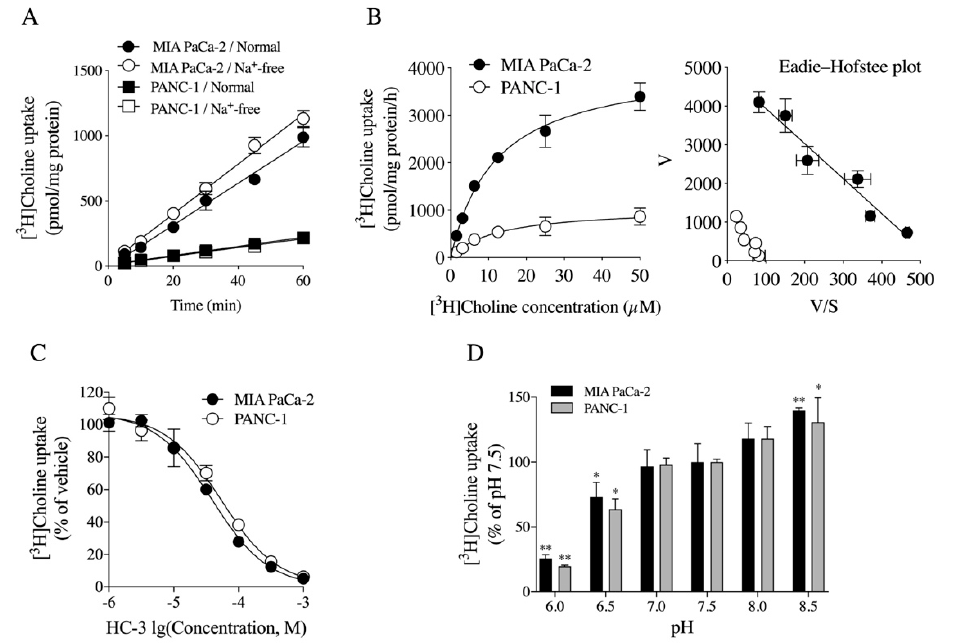
Figure 3. Properties of choline uptake in MIA PaCa-2 and PANC-1 cells. ( A ) Time course and Na + dependence of [ 3 H]choline uptake ( n = 4). Time course of [ 3 H]choline uptake fitted using nonlinear-regression analysis. ( B ) Kinetic analysis of [ 3 H]choline uptake in both cells ( n = 4). Cells taken up with [ 3 H]choline at concentrations of 1.56 – 50 µM for 20 min. Kinetic analysis of [ 3 H]choline uptake calculated by Michaelis–Menten equation showed K m of 12.0 ± 1.4 µ M and V max of 4120.0 ± 188.3 pmol / mg protein / h in MIA PaCa-2 cells and K m of 12.3 ± 3.3 µ M and V max of 1045.0 ± 107.6 pmol / mg protein / h in PANC-1 cells. Eadie–Hofstee plot of [ 3 H]choline uptake showing straight line in both cells (MIA PaCa-2 cells; R 2 = 0.9524, p = 0.0009, PANC-1 cells; R 2 = 0.8787, p = 0.0058). ( C ) E ff ects of choline-uptake inhibitor HC-3 on [ 3 H]choline uptake in MIA PaCa-2 and PANC-1 cells ( n = 4). Cells incubated with 1 µ M to 1 mM HC-3 for 20 min and then 10 µ M [ 3 H]choline uptake measured for 20 min. IC 50 value of HC-3 for inhibition of [ 3 H]choline uptake in MIA PaCa-2 and PANC-1 cells was 39.1 µ M and 54.2 µ M, respectively. ( D ) E ff ect of extracellular pH on [ 3 H]choline uptake in MIA PaCa-2 and PANC-1 cells ( n = 4). Uptake of 10 µ M [ 3 H]choline measured for 20 min at di ff erent conditions from pH 6.0 to pH 8.5; * p < 0.05 and ** p < 0.01, and one-way ANOVA with Dunnett’s multiple-comparisons test compared to pH 7.5.